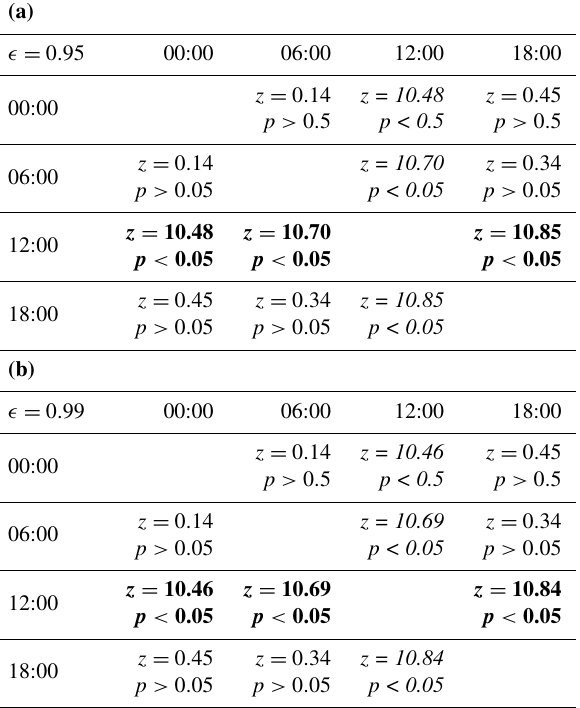
Table 7. Results for Wilcoxon rank sum tests between modeled temperature inversions at 00:00, 06:00, 12:00, and 18:00 during the winter using an emissivity value of (a) (cid:15) = 0 . 95 and (b) (cid:15) = 0 . 99. Inversions ( T surface − T air ) were calculated from ERA5 and Divide AWS data. Bolded cells indicate a larger inversion in the column hour; italicized cells indicate a larger inversion in the row hour; and standard-font cells indicate no significant difference between the